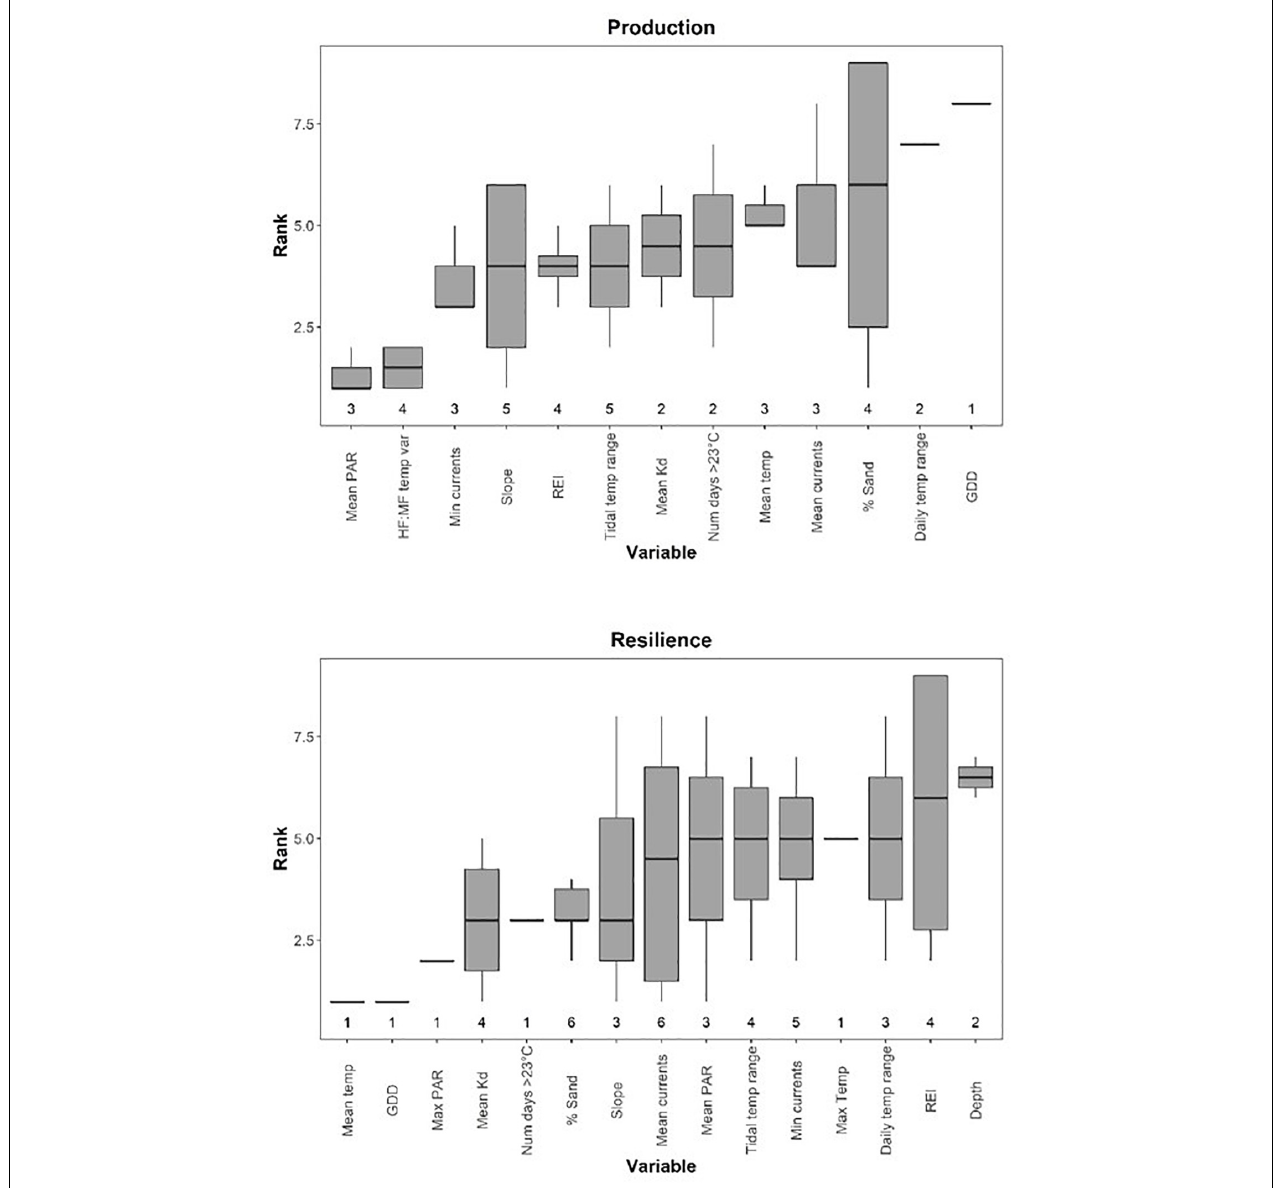
FIGURE 6 | Boxplots of environmental variable ranks in multiple regressions of metrics of production (top panel) and resilience (bottom panel) , with lower ranks representing higher importance. Ranks represent averages across squared structure coefficients ( r s 2 ), commonality metrics ( r 2 ), general dominance, and Relative Importance Weights. Boxes show the median, first, and third quartiles. Upper and lower whiskers correspond to the largest and smallest values, meeting the condition that they are no further than 1.5 IQR from the first and third quartiles. Numbers for each variable represent the number of models each variable was selected in. Variable abbreviations given in Table 1